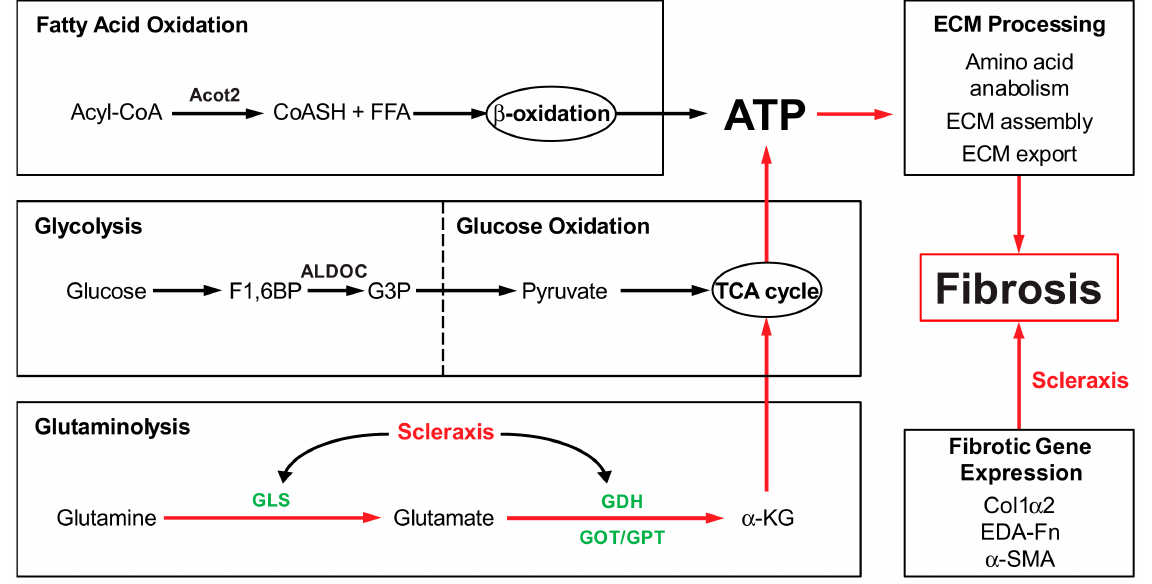
Figure 6. Scleraxis (red text) regulation of gene expression in fibrosis. Extracellular matrix (ECM) synthesis and processing require large quantities of ATP, which may be derived from various in- tracellular metabolic pathways, including fatty acid b-oxidation, glycolysis, glucose oxidation, and glutaminolysis. Key enzymes of each pathway are depicted, including those of glutaminolysis (green text). Red arrows highlight mechanisms that may contribute to cardiac fibrosis: scleraxis regulates GLS1 expression, per the present results, and shows evidence of regulation of other glutaminolysis enzyme genes. Scleraxis also directly transactivates a variety of pro-fibrotic genes, including ECM components Col1 α 2 and EDA-Fn; thus, scleraxis may regulate fibrosis by controlling both ECM gene expression and glutaminolysis genes to provide the energy necessary to support